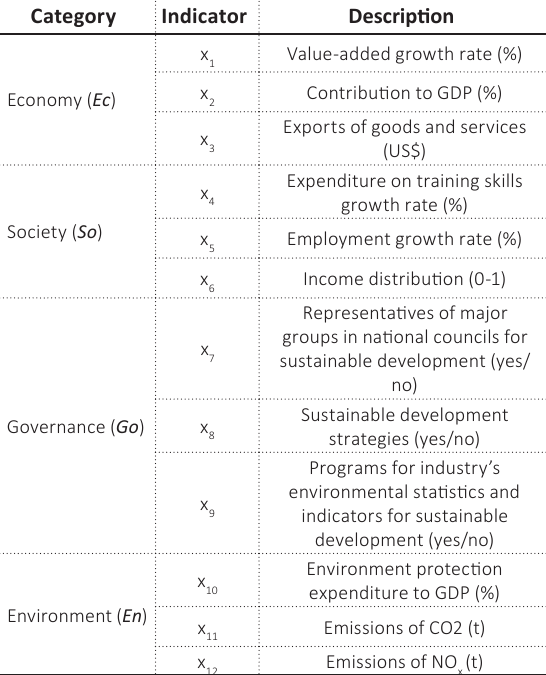
Figure 3: (P.1) is a calculation of the Sustainable Development Index (SDI), and the last one (P.2) is mathematical modeling, where the optimization variable is CO2 emissions, and SDI level should be maximized.